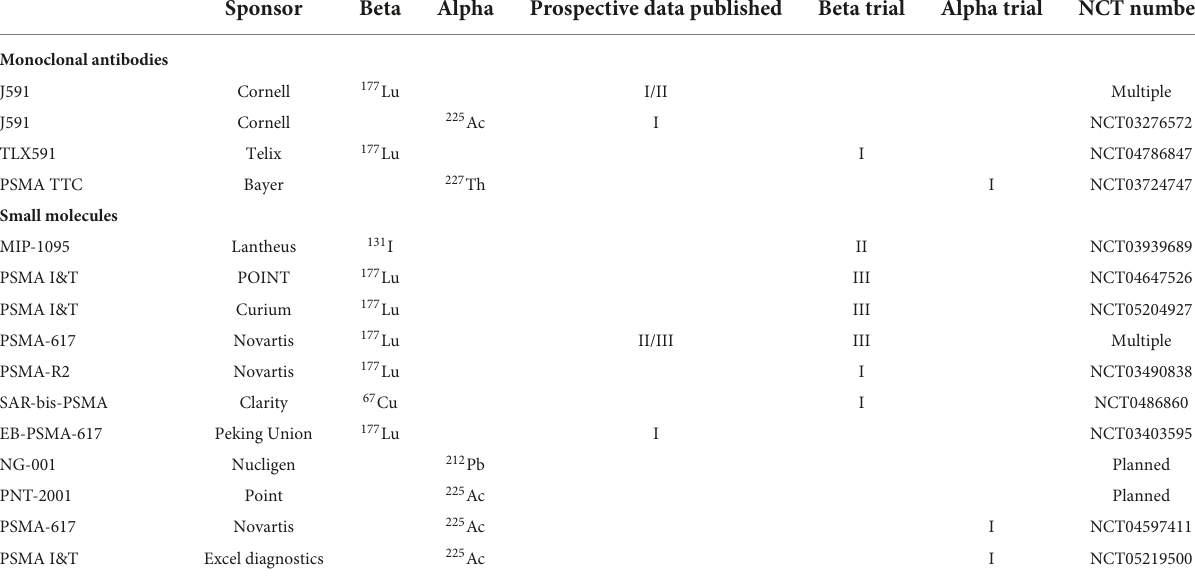
TABLE 1 Synopsis of prostate specific membrane antigen (PSMA) targeted molecules in current development or